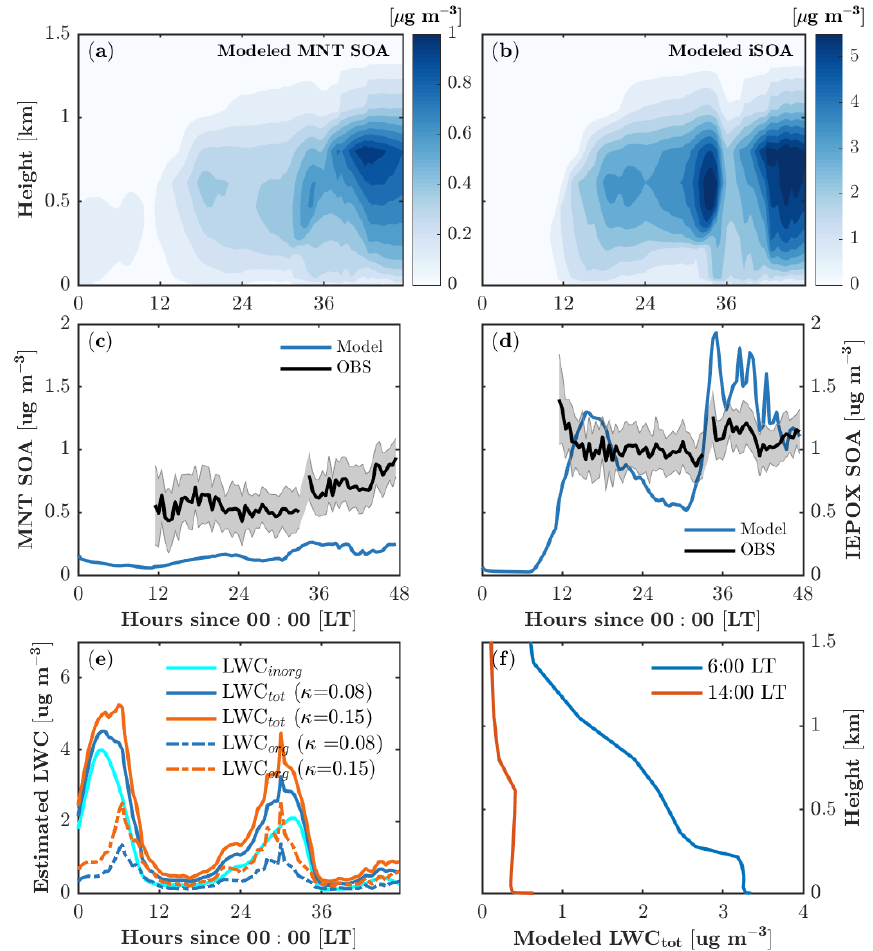
Figure 7. Monoterpene-derived secondary organic aerosol (MNT-SOA) (a) and isoprene-derived secondary organic aerosol (iSOA) (b) as a function of time and height. (c, d) Comparison of modeled MNT-SOA and IEPOX-SOA with observations at 30m. (e) Time series of calculated liquid water content (LWC) with different hygroscopicity growth κ . (f) Vertical profiles of modeled LWC during the daytime (14:00 local time) and in the early morning (6:00 local